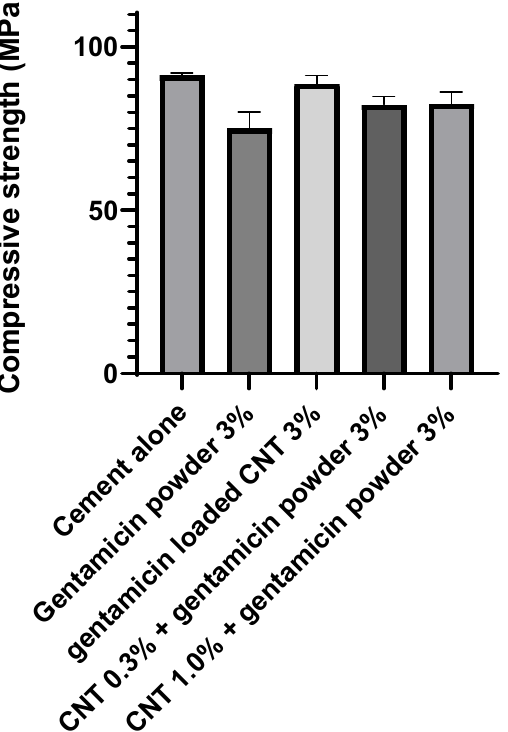
Figure 6. Compressive strength for different types of bone cement after aging at 37 °C for 3 months ( n = 6 ± SD).